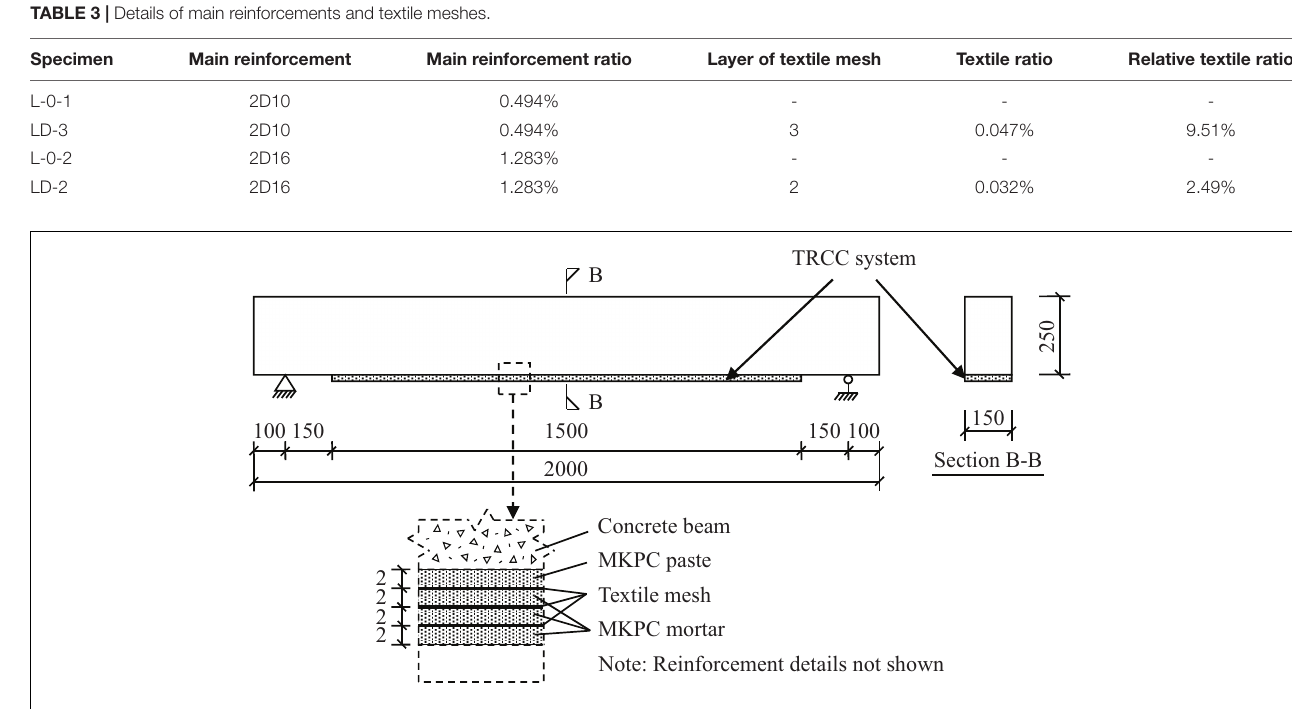
FIGURE 2 | Schematic view of strengthened specimen (unit: